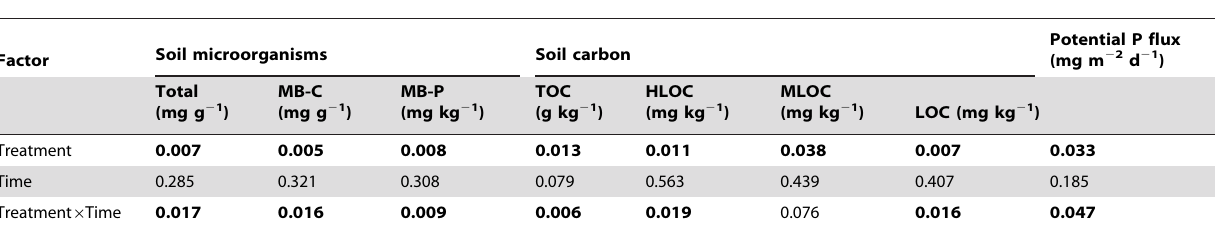
Table 3. Results of two-way analysis of variance (repeated ANOVA) showing the p -values for soil microorganisms and soil carbon and potential phosphorus (P) flux under experimental warming and sampling time. MB-C: microbial carbon, MB-P: microbial phosphorus, TOC: total organic carbon, HLOC: highly labile organic carbon, MLOC: mid-labile organic carbon, and LOC: labile organic